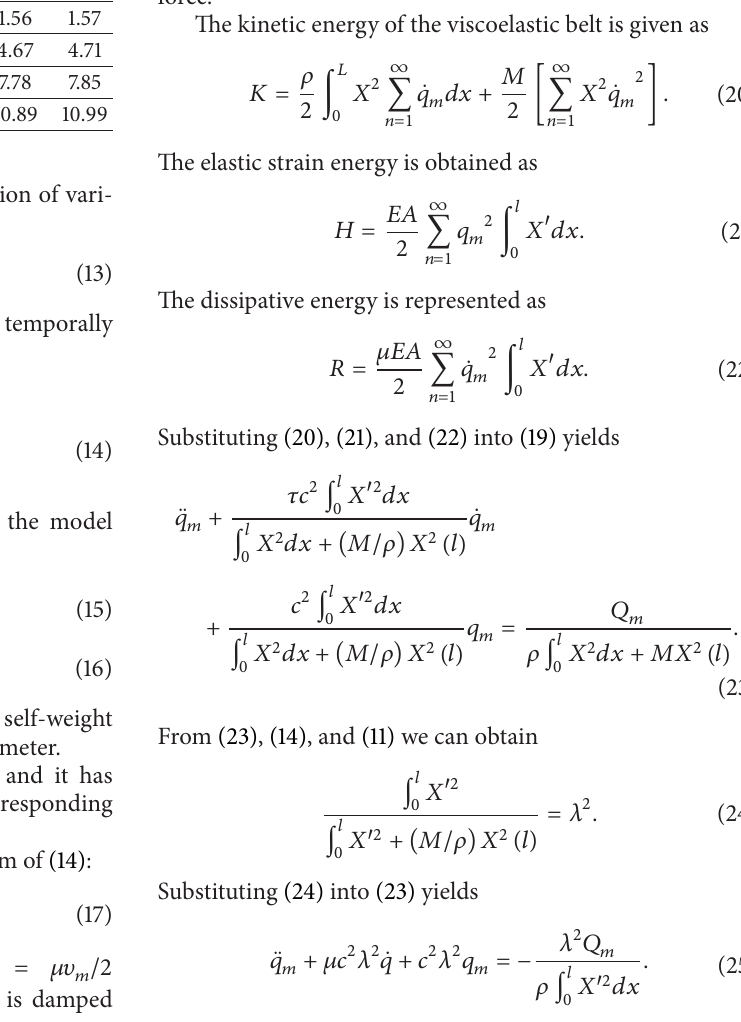
Table 1: Value of 𝜂 corresponding to different 𝛼 . 𝛼